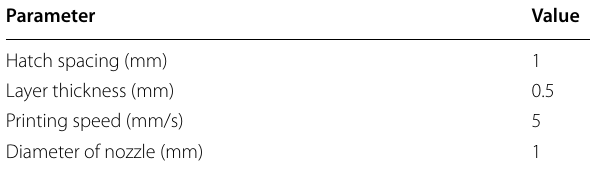
Table 1 3D printing process parameters for